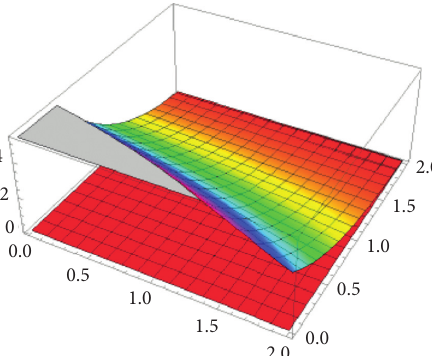
Figure 4: 0 is the common fixed point of H and K